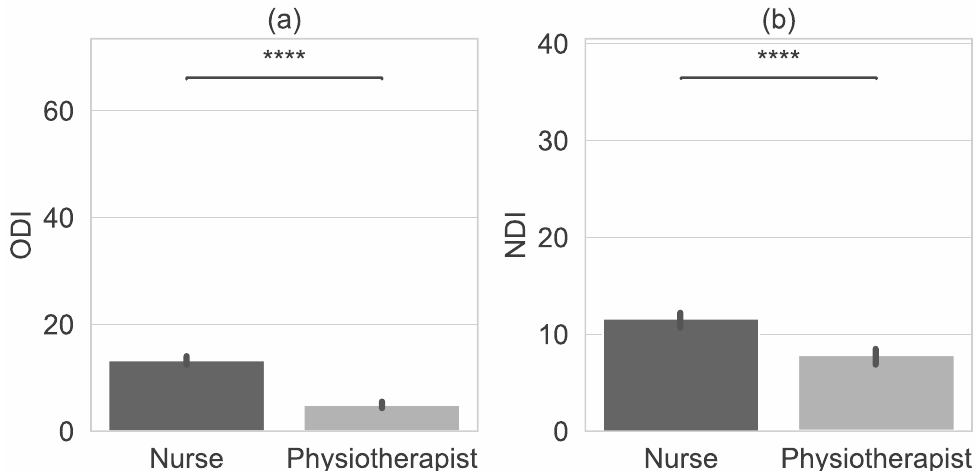
Figure 2. Characteristics of Physiotherapists and Nurses with error bars and p -value annotation leg- ends ( a ) Oswestry Disability Index (ODI) ( b ) Neck Disability Index (NDI) values. ****: p <= 1.00e-04.